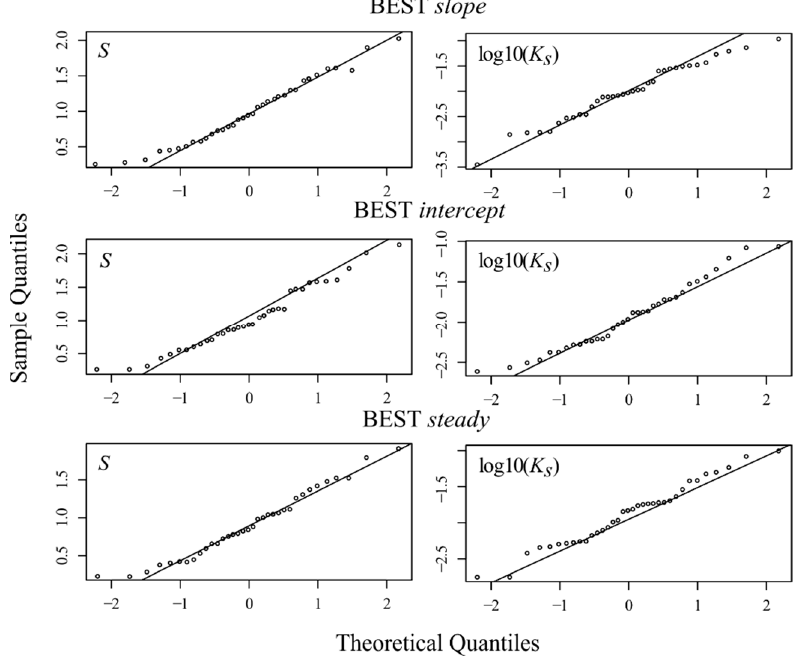
Figure 7. QQ plots of parameters K s and S by the three BEST methods. Table 5. Normality test Kolmogorov–Smirnov on the estimates of K s and S by the three BEST methods.